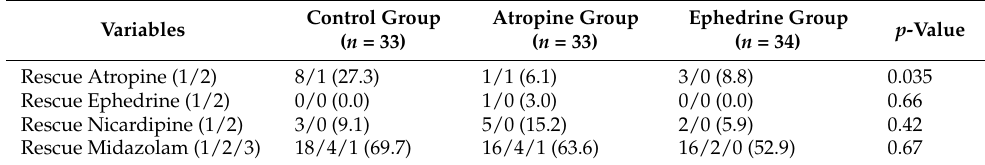
Table 2. Incidence rates of rescue treatment for hemodynamics and sedation.